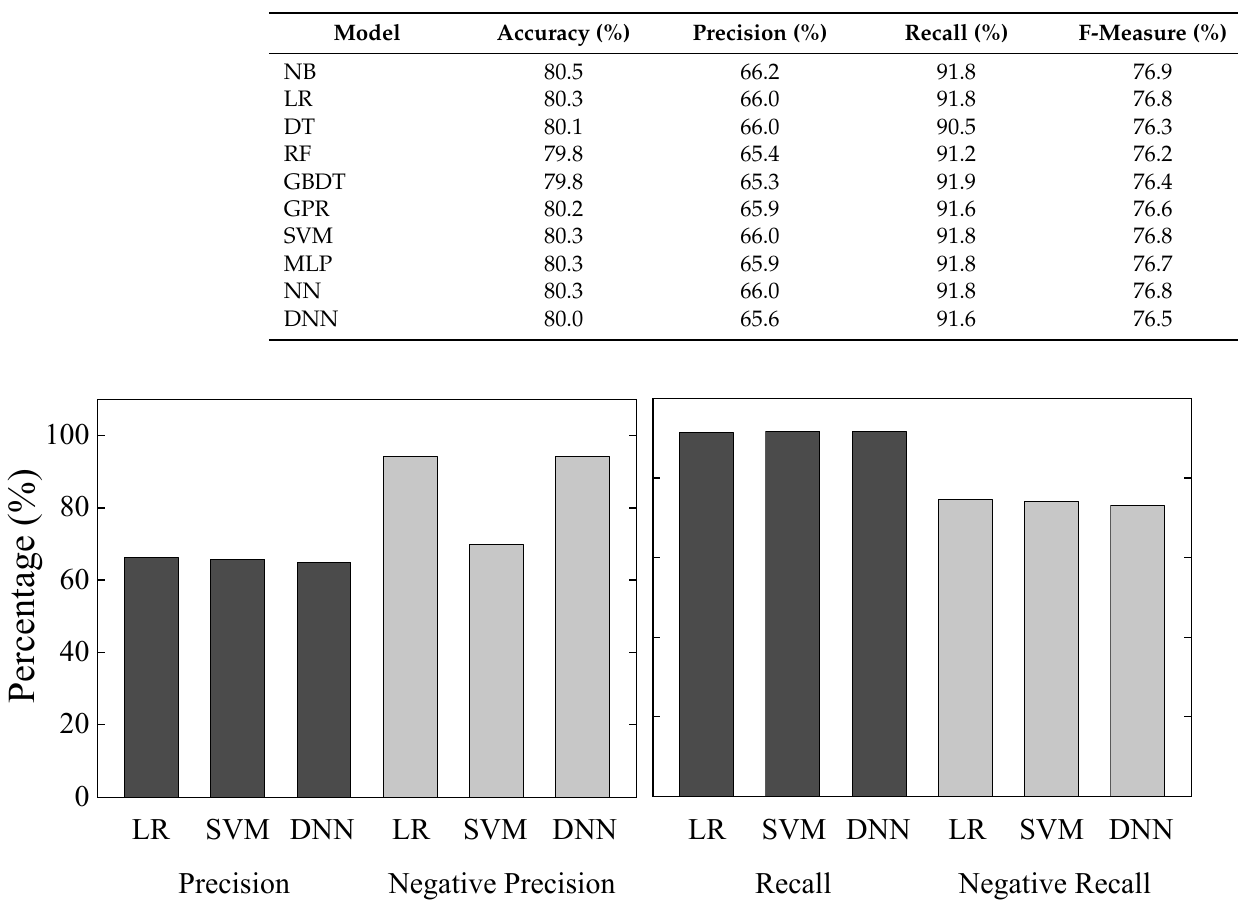
Table 16. Comparison of results of machine learning models based on analysis considering globe temperature and cooling.